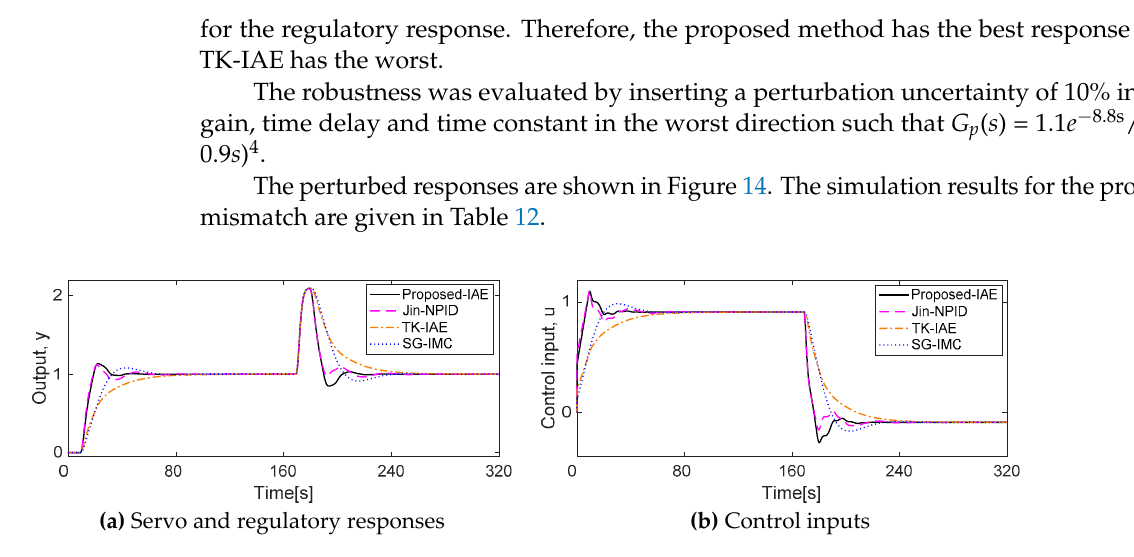
Figure 14. Servo and regulatory responses for process 4 under 10% mismatch. Table 12. Quantitative comparison of performances for process 4 under 10% mismatch.